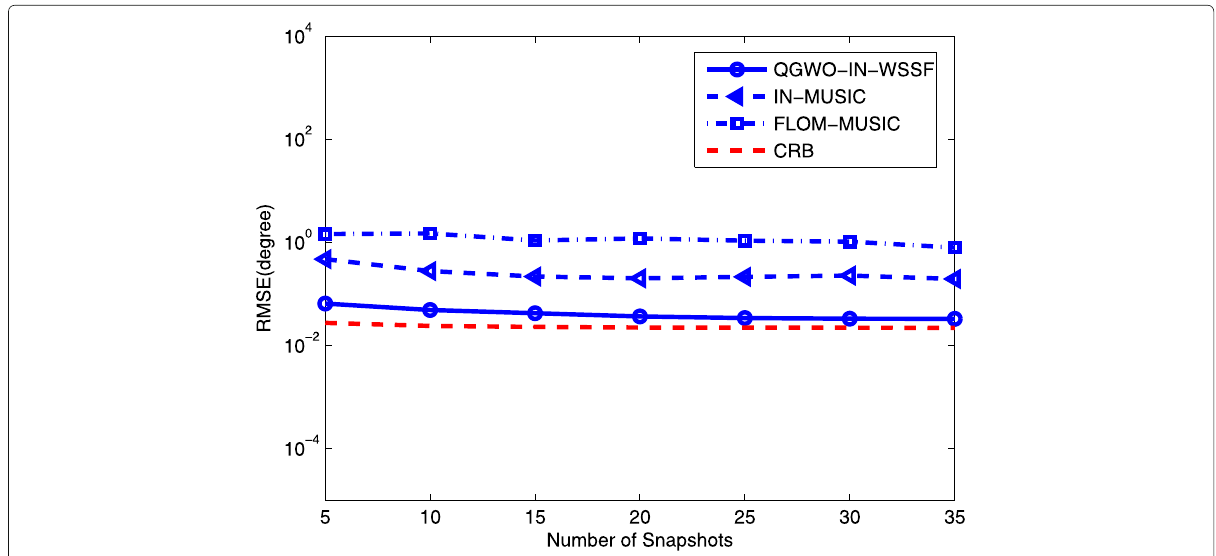
Fig. 1 RMSE curves and CRB versus the number of snapshots for two independent sources with GSNR = 20dB and α =